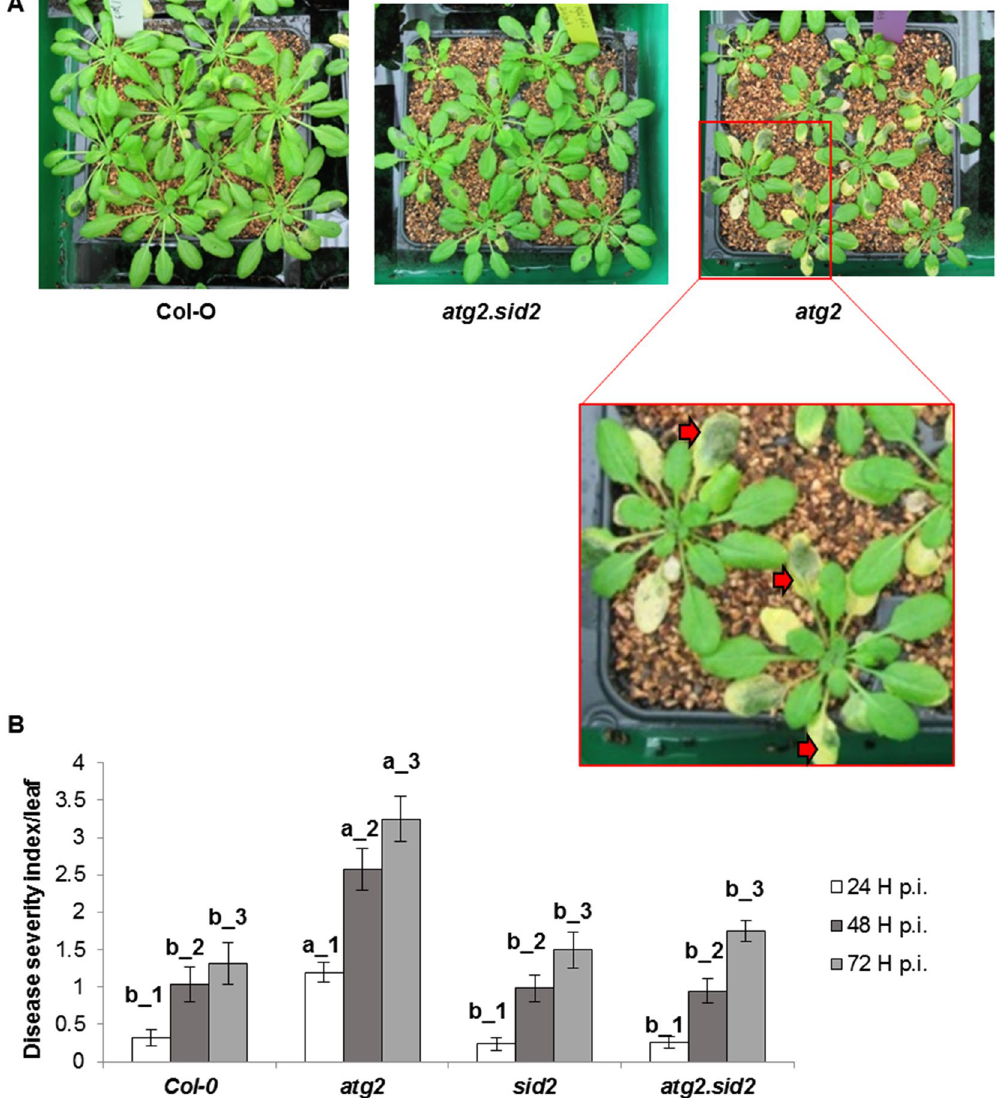
Figure 3. Susceptibility of atg2 mutant relies on SA. ( A ) Pictures of 6 week-old Arabidopsis indicated genotypes inoculated with D. dadantii. In the enlargement of atg2 mutant inoculated plants, red arrows indicate yellow zones of early senesce. ( B ) Symptom severity at indicated time points on indicated genotypes. Bars represent standard deviation. N = 30. Experiments were performed three times with similar results. Different letters in the graph indicate statistical significance between genotypes at the same time point (one-way ANOVA with Tuckey’s test; P <